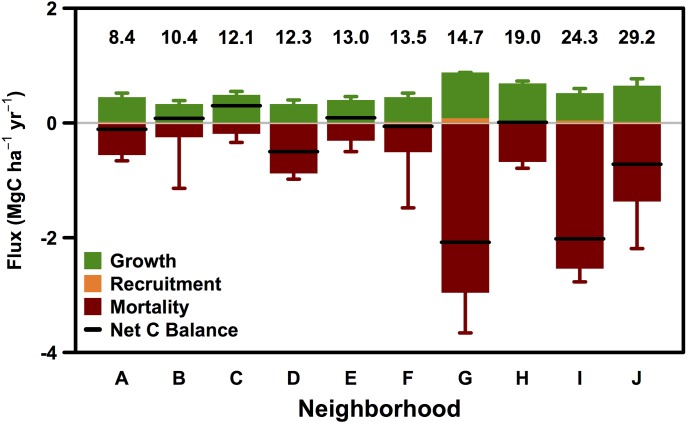
Neighborhood C balance.a) Neighborhood group net carbon flux (Mg C ha-1 yr-1) throughout the City of Boston as a balance of biomass change due to mortality, recruitment, and tree growth between 2006 and 2014. Error bars represent standard error. Numbers above bars represent 2014 biomass stock (Mg C ha-1). See S2 Table for neighborhood descriptions and statistics.